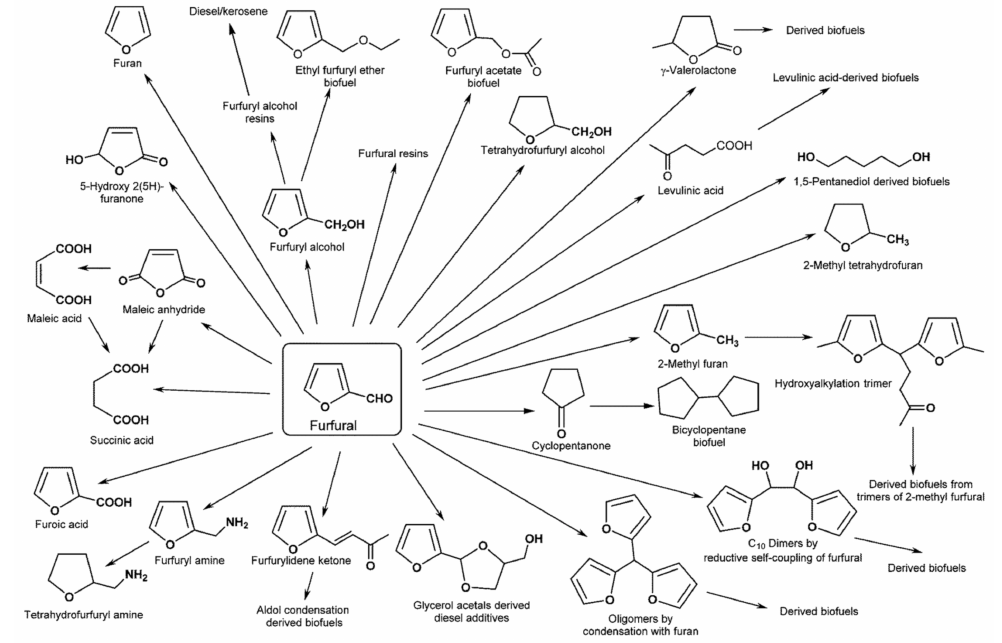
Figure 2. Furfural as a platform chemical